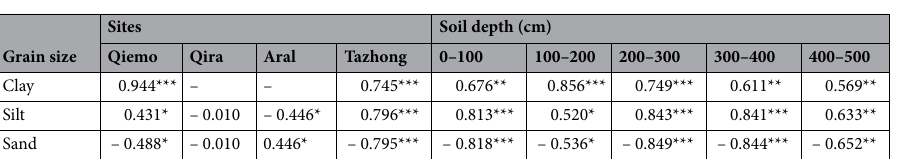
Table 1. Correlation coefficients between the clay, silt, and sand contents and the fractal dimension. * p < 0.05, ** p < 0.01, *** p < 0.001.